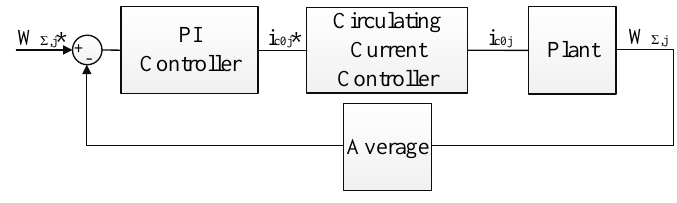
Figure 3. Leg energy balancing closed loop control